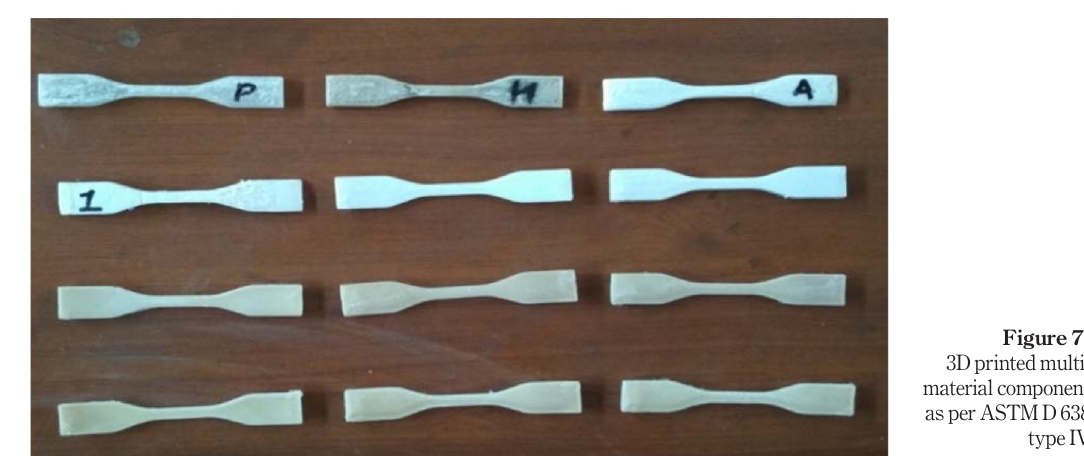
Figure 7. 3D printed